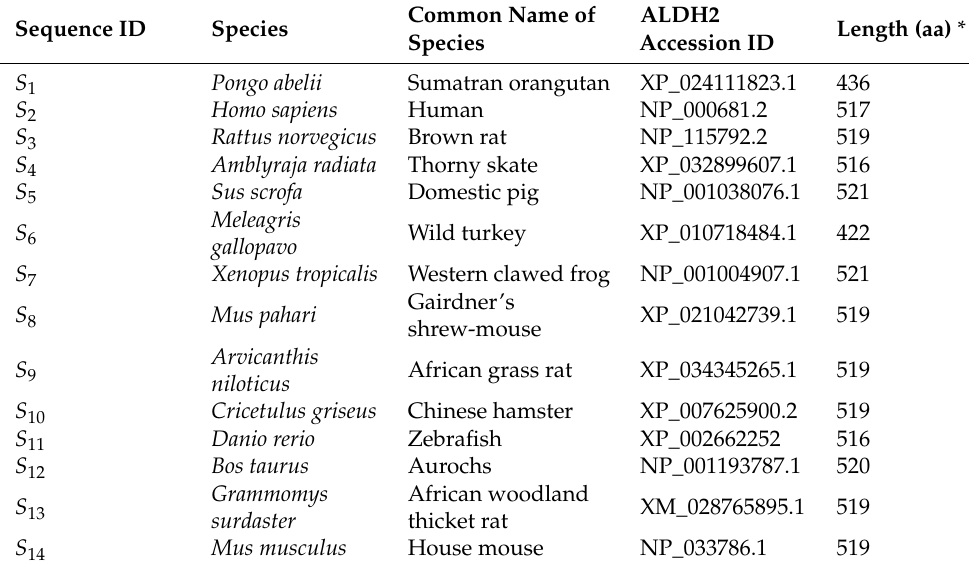
Table 1. Fourteen species and their respective ALDH2 protein